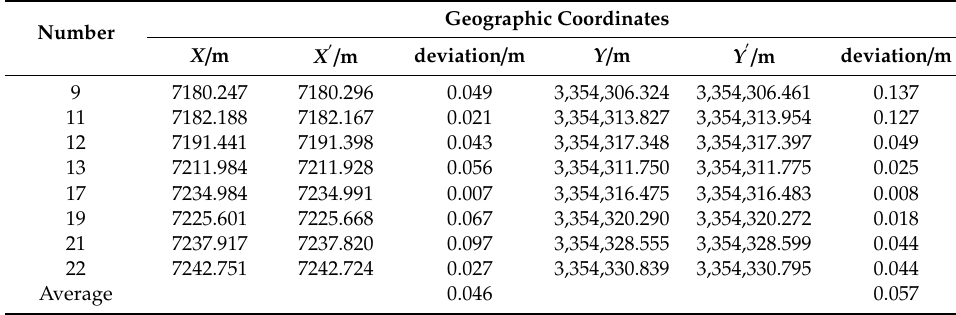
Table 3. Accuracy analysis of ArcGIS registration results.